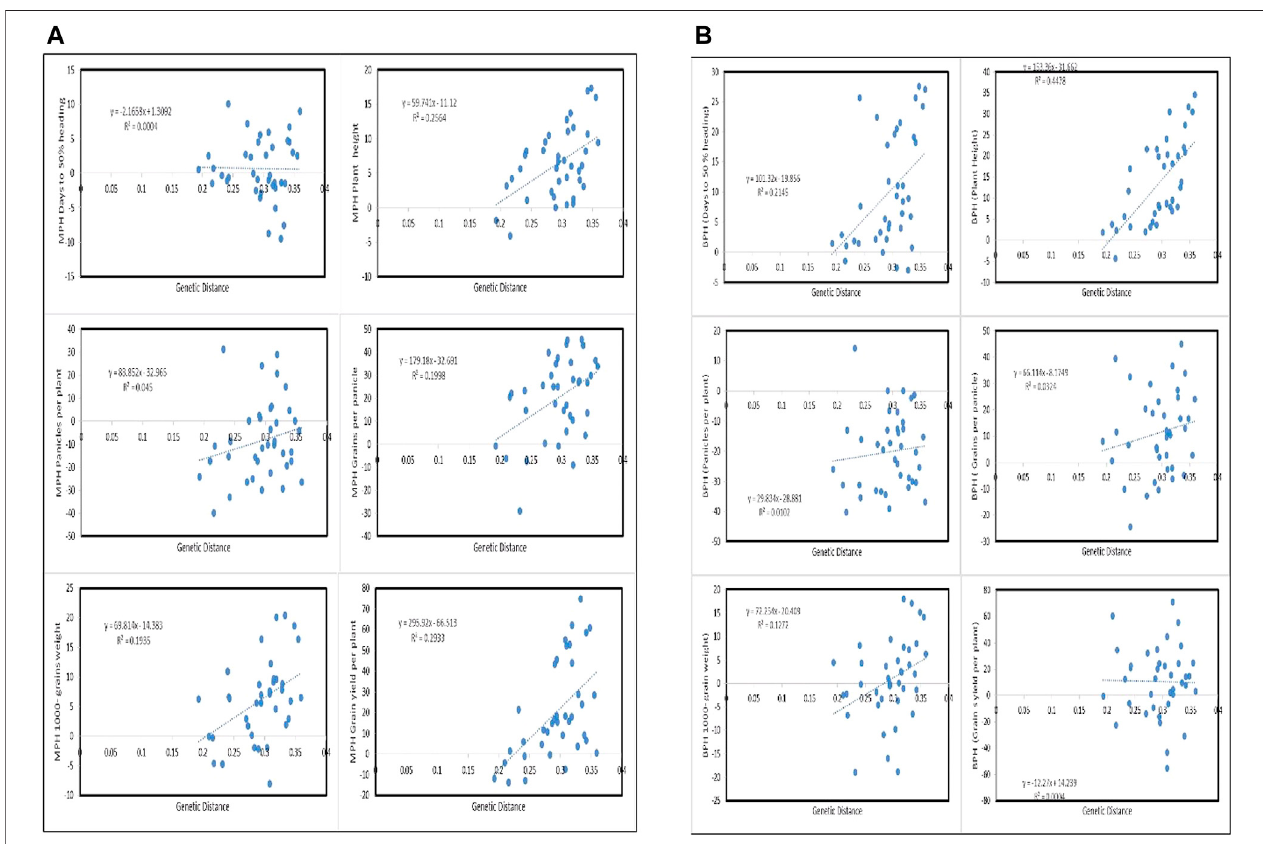
FIGURE 3 | Representation of mid-parent (A) and better-parent (B) heterosis association of F1 hybrids with the genetic distances between their corresponding parents.